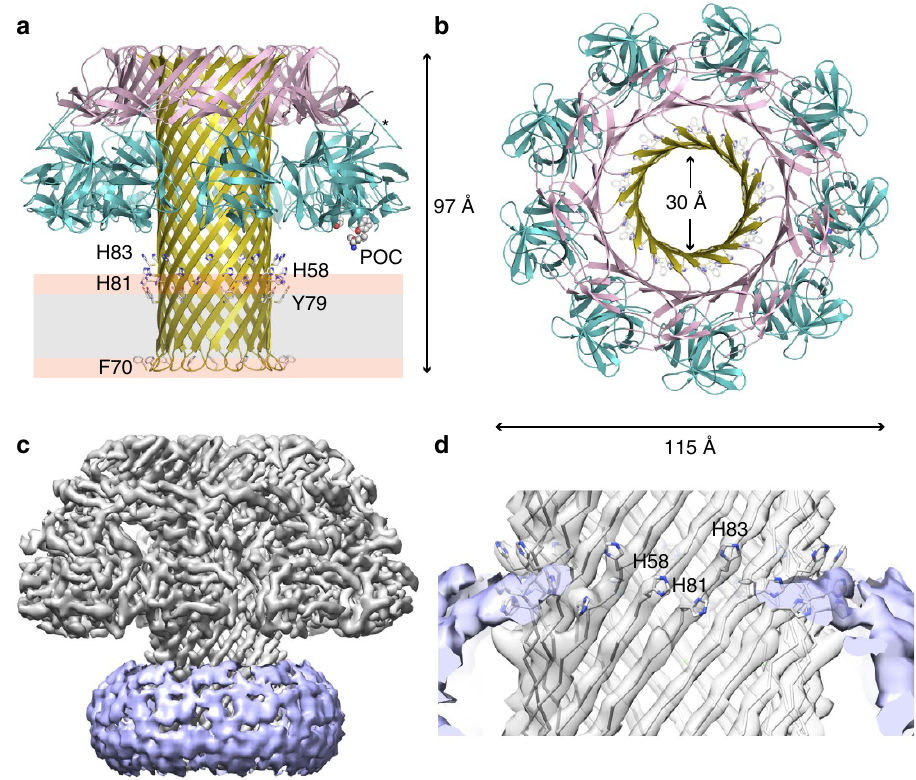
Figure 2 | Atomic model of the lysenin pore. Cartoon representation of lysenin shown from the side ( a ) and extracellular views ( b ). The three domains of lysenin are coloured as in Fig. 1: b -hairpin domain (olive), cap domain (pink) and receptor-binding domain (cyan). The dimensions of the complex and the pore are shown as C a –C a measurements and the approximate location of the bilayer is drawn with the phospholipid head groups shown in orange and the hydrophobic core in grey. The aromatic rings of Phe70 and Tyr79 are shown in stick representation, as are the histidine residues directly above the Tyr79 ring. The phosphocholine-binding site residues (POC) are shown as spheres and the asterisk indicates the flexible coil connecting the receptor-binding domain to the cap domain. ( c ) Surface representation of the Gaussian filtered detergent shell (purple) around the sharpened lysenin map. ( d ) Close view of the extracellular side of the detergent belt highlighting the three histidine